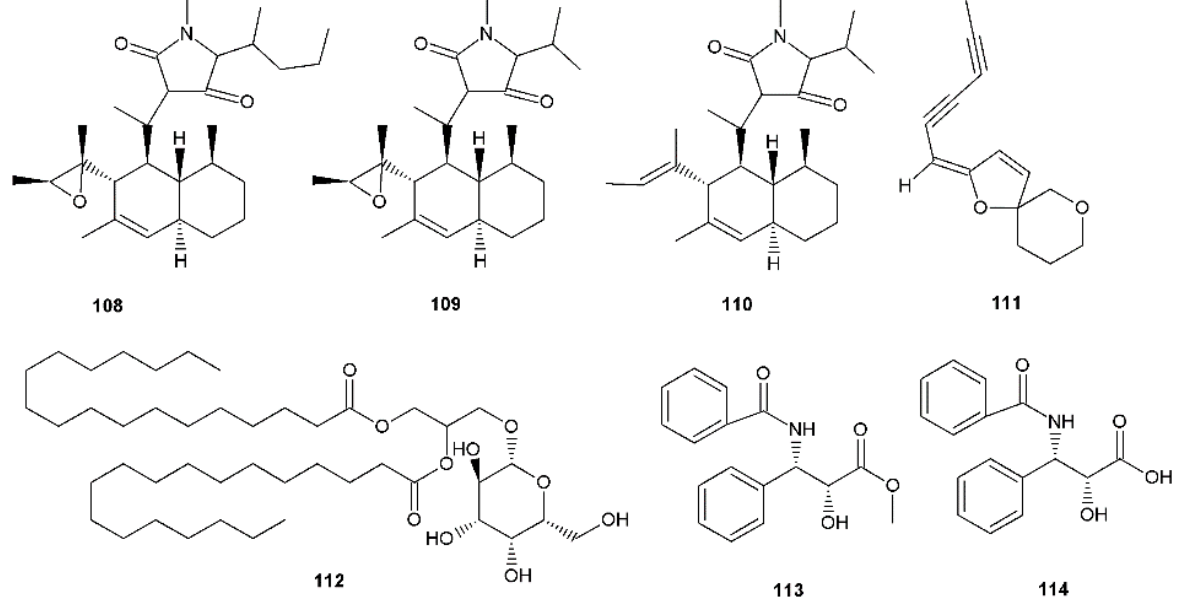
Figure 5. Miscellaneous compounds with antiherpetic activity.